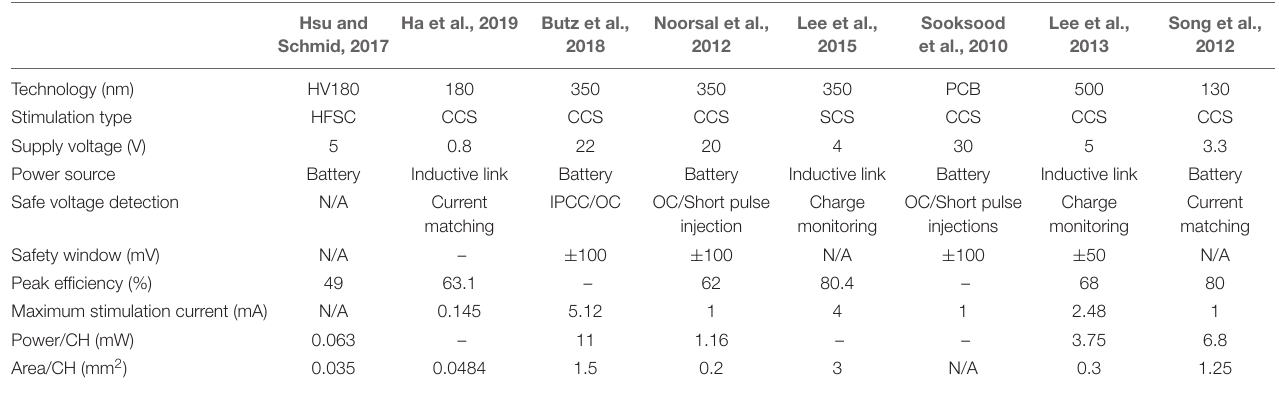
TABLE 1 | Comparison of the parameters in neural stimulation